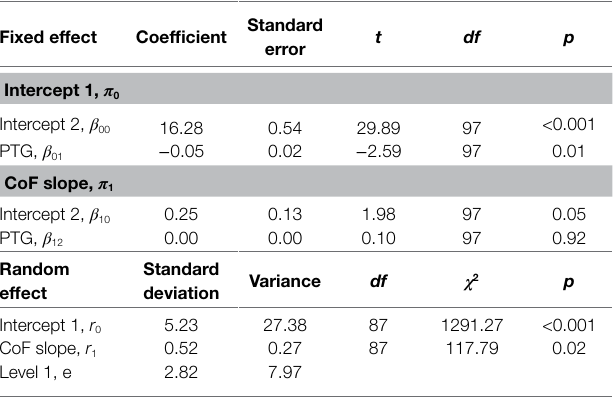
TABLE 5 | The moderating effect of PTG in the effect of COVID-19-related restrictions and concerns on anxiety.